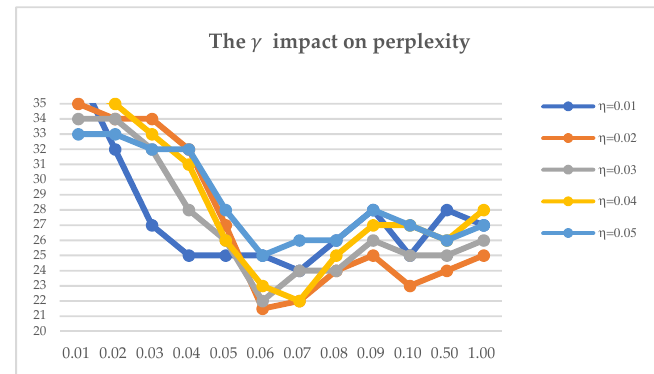
Figure 7. The 𝜂 impact on perplexity. Figure 7. The η impact on perplexity.